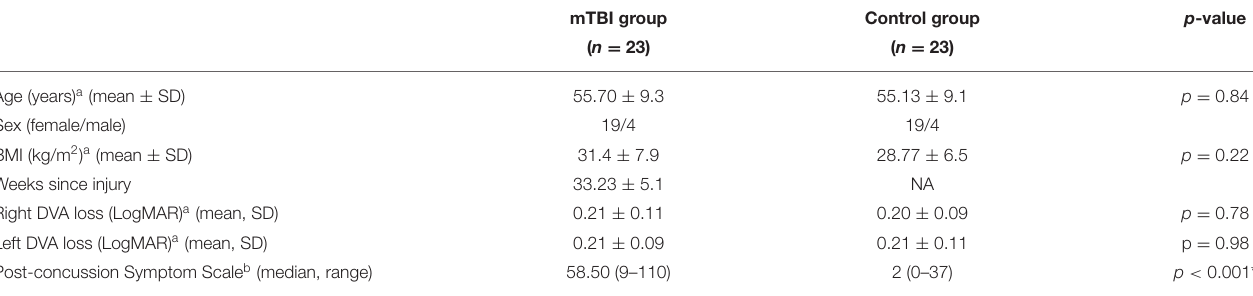
TABLE 1 | Participant characteristics between mTBI and control